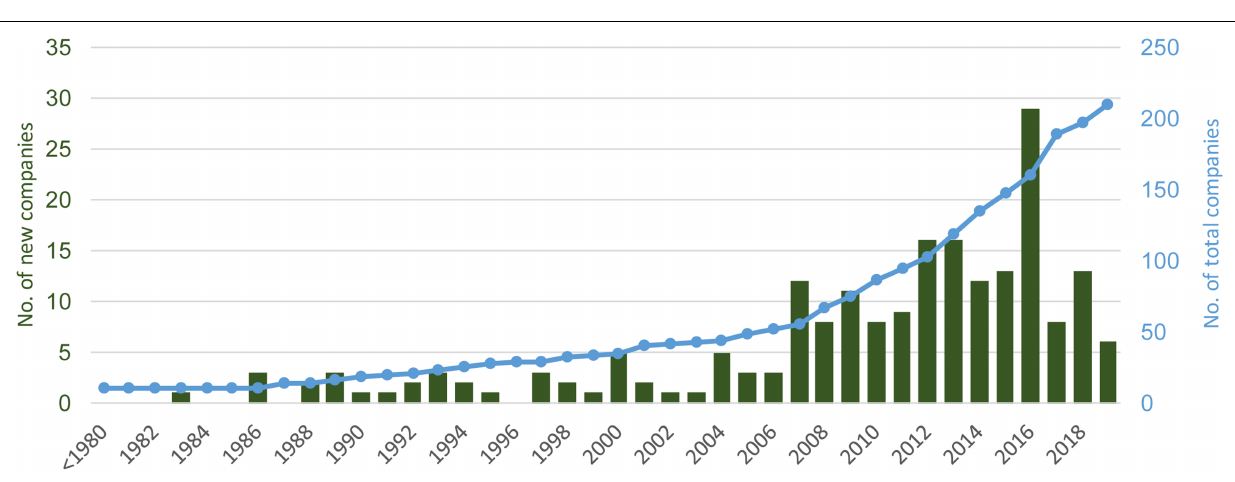
FIGURE 5 | Number of algae producing companies currently operating in Europe (starting activity since 1926). The values shown represent the number (left axis) and the accumulated (right axis) number of companies per year from the companies currently